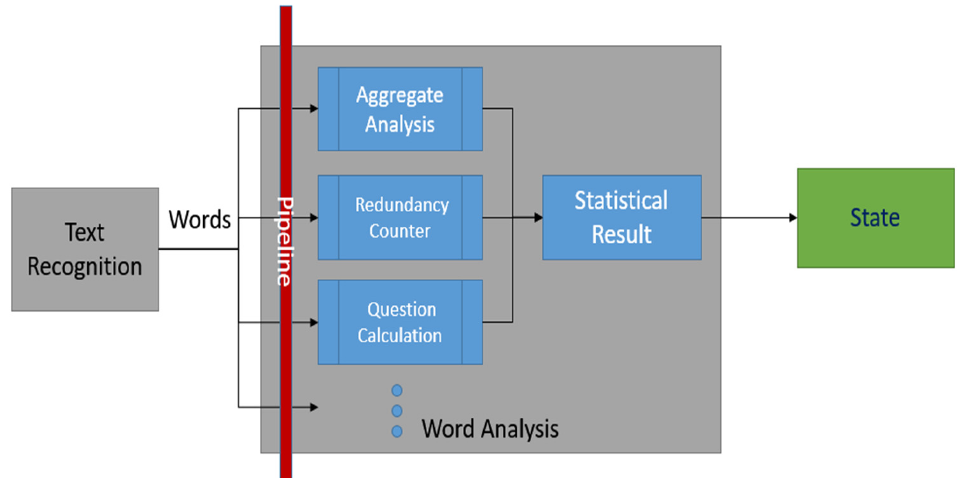
Figure 6. Flow chart of speech conversion text statistics for teaching status results.